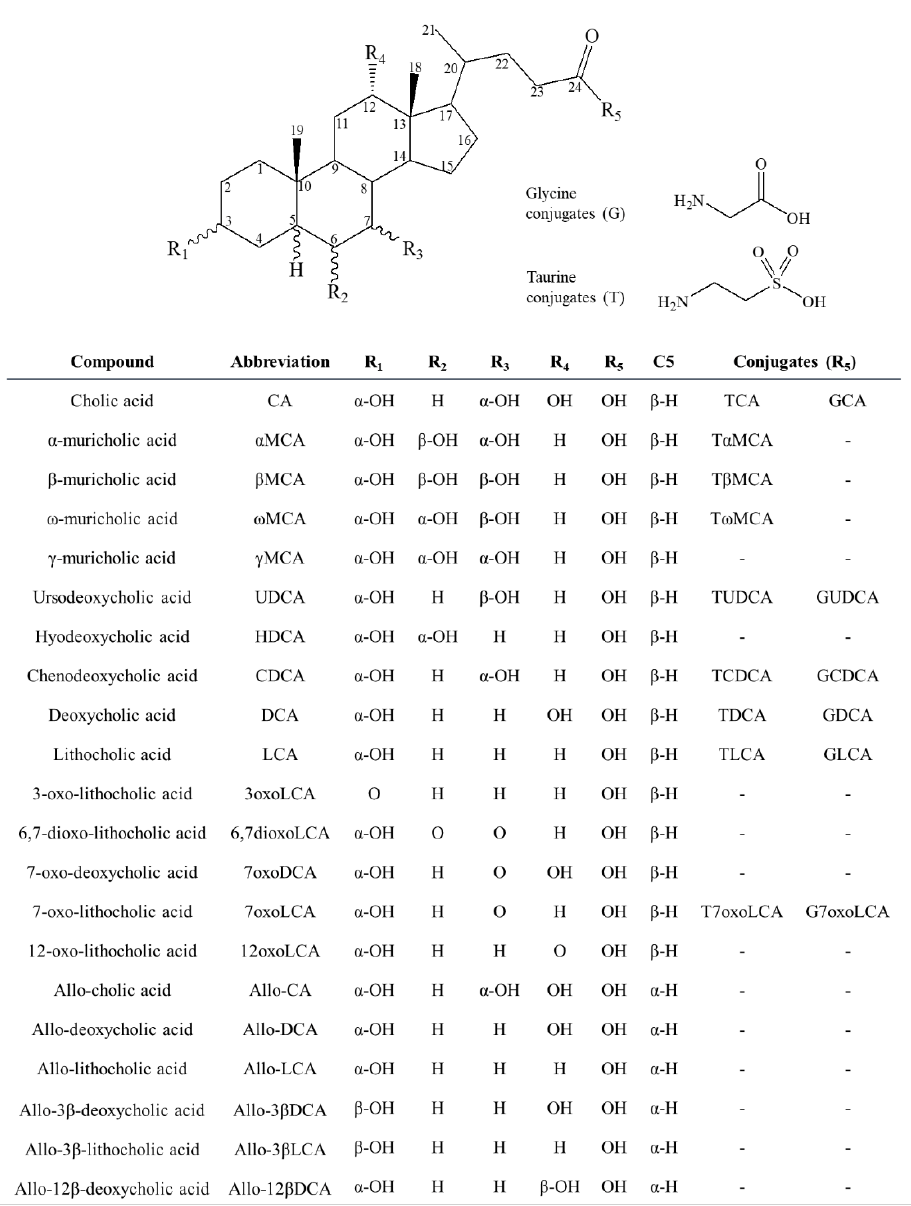
Figure 1. Chemical structures of bile acids included in the LC-MS/MS method.